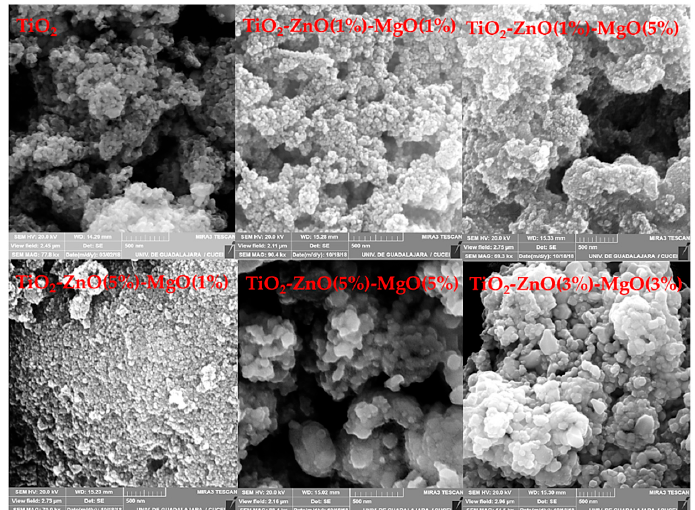
Figure 1. Scanning electron microscopy (SEM) images from pure TiO 2 and mixed oxide materials.